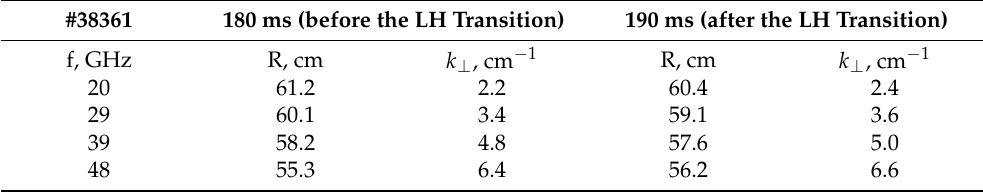
Table 1. Radii and wave vector values for discharge #38361 calculated by a ray tracing code.